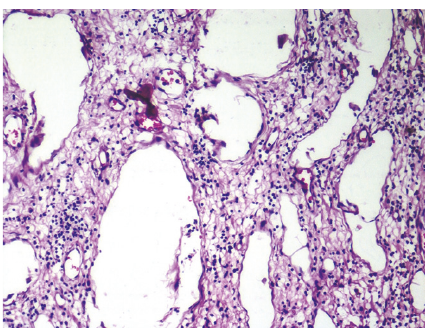
Figure3:Histopathologicalexaminationshowingdilatedlymphatic channels lined by endothelium (hematoxylin and eosin, 10x total magnification high